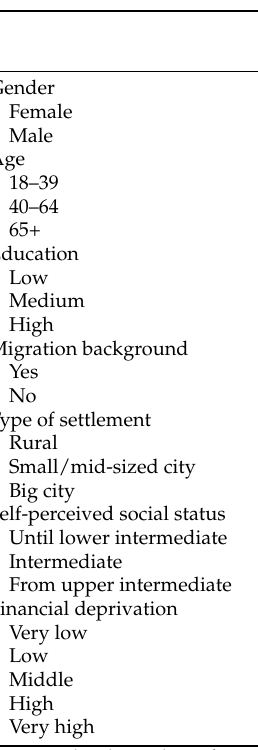
Table 1. Sociodemographic characteristics of the